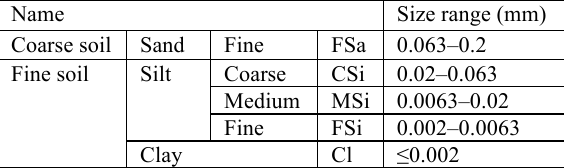
Table 1 . ISO 14688-1:2002 soil classification for types of underwater cave sediments susceptible to interfere with photogrammetric studies